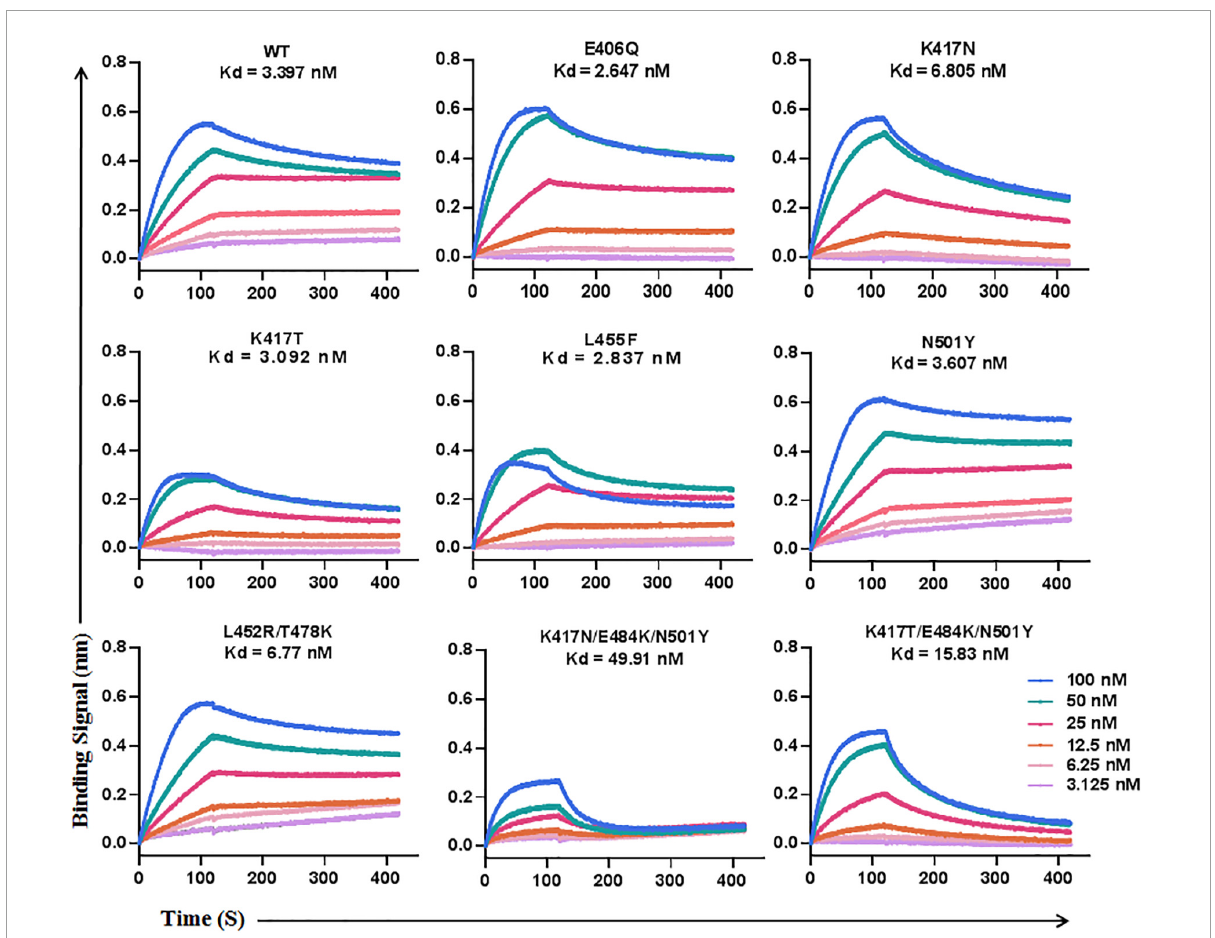
FIGURE3 The binding affinity of LCB1 with RBD proteins determined by biolayer interferometry. A recombinant His-tagged RBD protein with wild-type sequence or mutations was loaded onto an NTA biosensors and equilibrated before the baseline was set to zero at t = 0. The binding kinetics was guided by associating in different concentrations of LCB1 for 120 s and disassociating for 300 s. The equilibrium dissociation constant (Kd) was calculated.